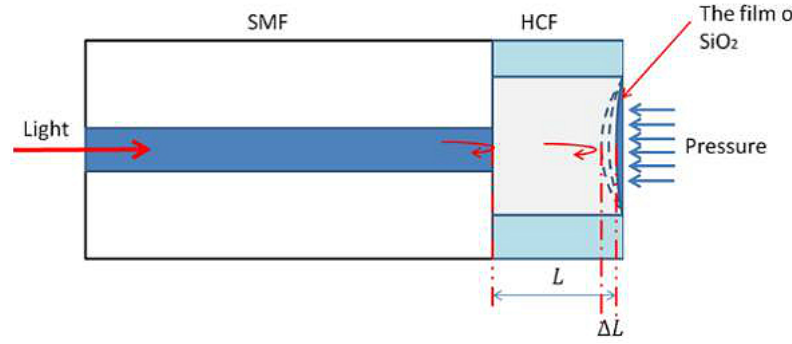
Figure 6. Schematic diagram of sensor probe structure.